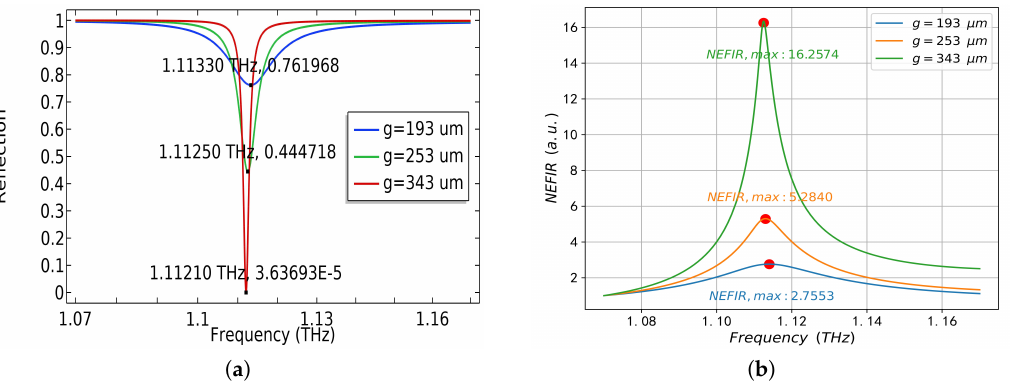
Figure 6. The reflection spectrum for di ff erent coupling gaps ( a ) and the corresponding NEFIR ( b